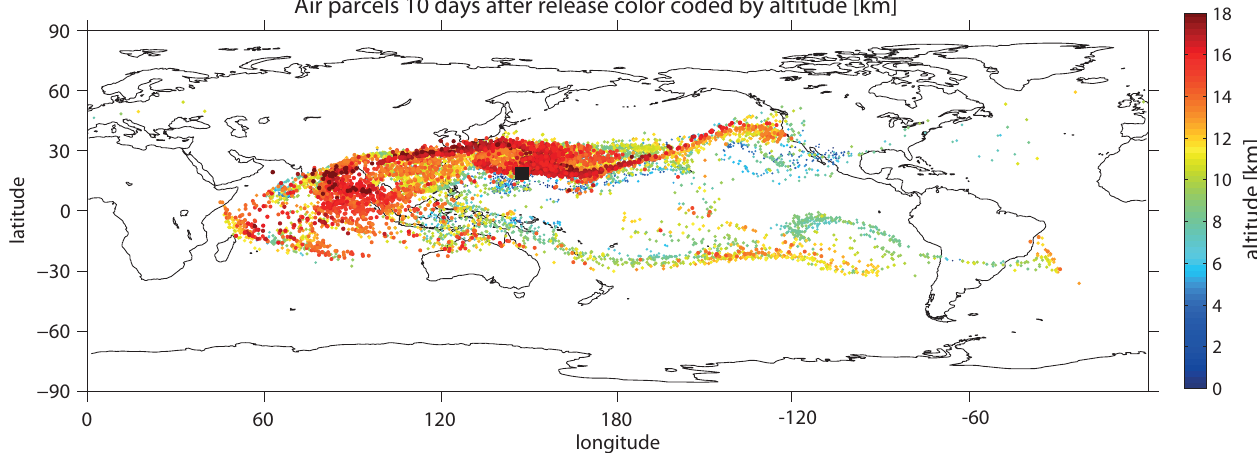
Fig. 1. Spatial distribution on 24 October 2009, of air parcels originally released at the surface at 19 ◦ N, 148 ◦ E on 14 October 2009, i.e. 10 days after their release. The air parcels are color coded by altitude. Air mass transport including convection has been calculated with the Lagrangian particle dispersion model